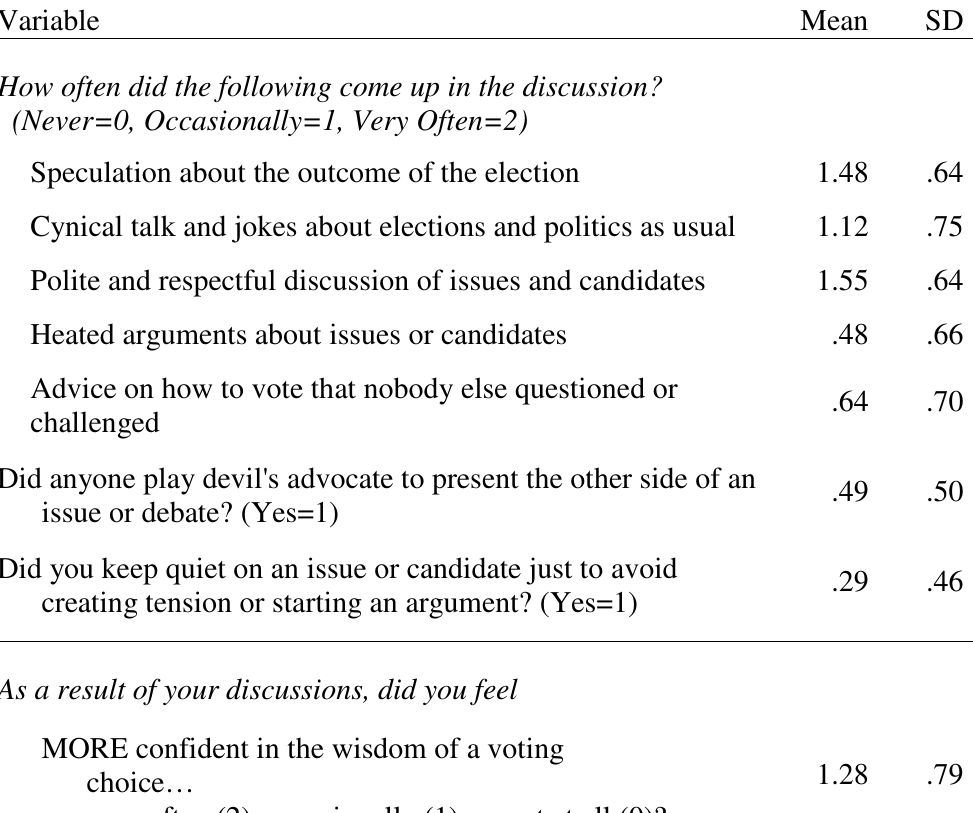
Table 2 Descriptive statistics for control variables, discussion features, and outcome measures for the statewide random samples of Washington and Oregon voters